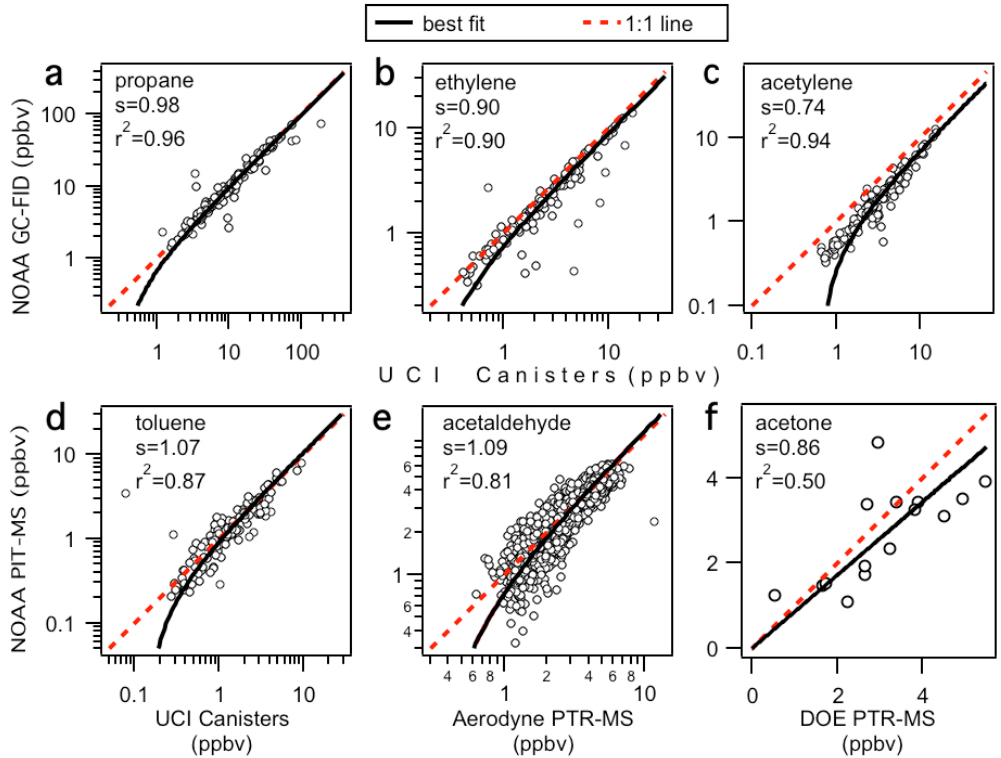
Figure 2. Selected results of the comparison of VOC measurements at the T1 site during MILAGRO. Panels (a–c) compare the measurements of the NOAA GC-FID and the UC Irvine canister measurements for the same compound. Panel (d–f) compare measurements made by the NOAA PIT-MS to made from the UC Irvine Ccanisters and by the PTR-MS instruments on the Aerodyne Mobile Laboratory and the DOE G1 aircraft, respectively. Slopes from linear regressions (s) and correlation coefficients, r 2 , for comparisons are tabulated in Table 2.